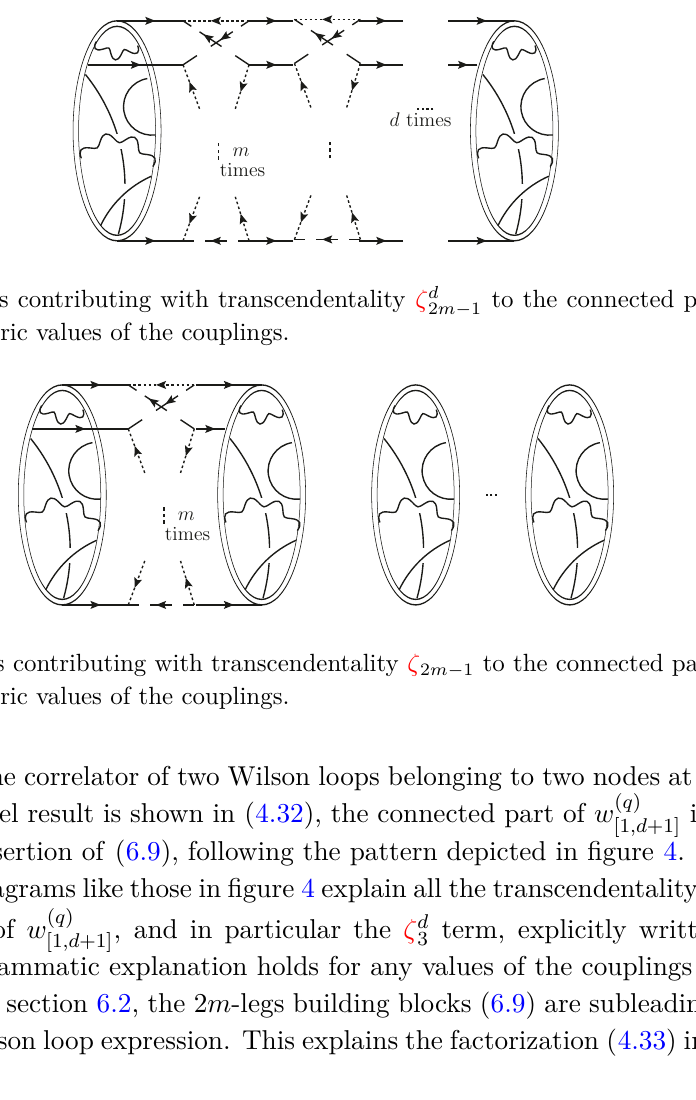
to the connected part of w ( q ) 2 m − 1 [1 ,d +1]